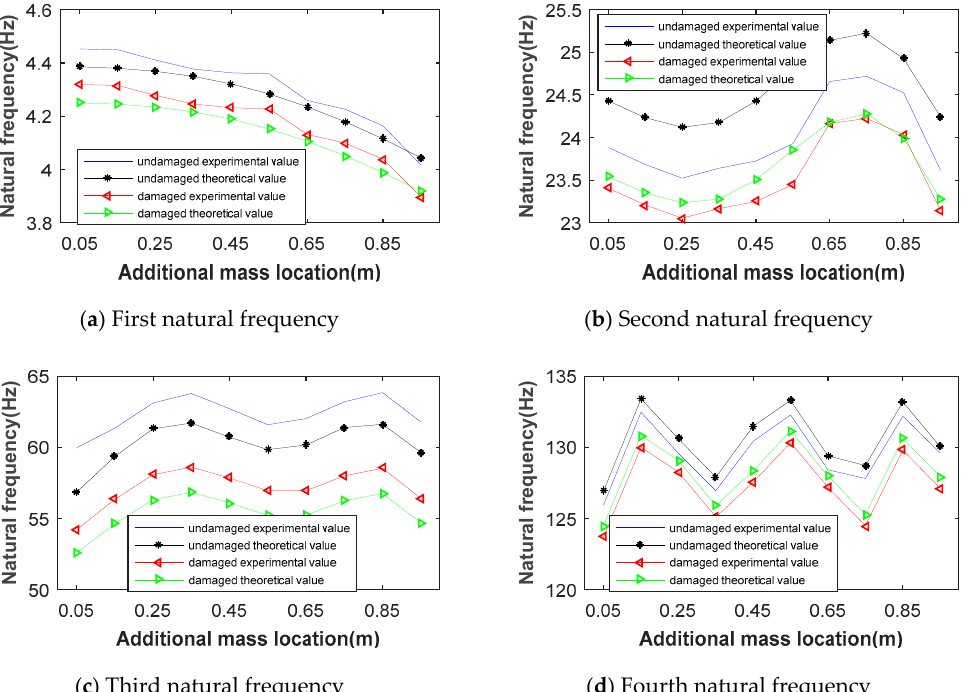
Figure 13. Experimental and computed values of the first four natural frequencies of the cantilever beam with double damage.